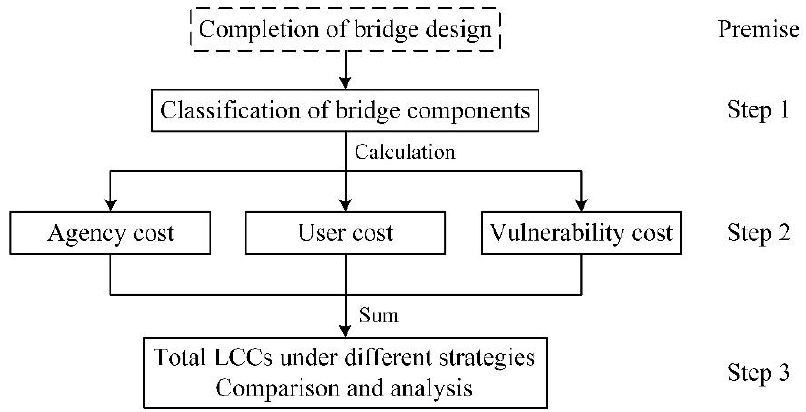
Figure 2. Flowchart of life-cycle cost analysis.